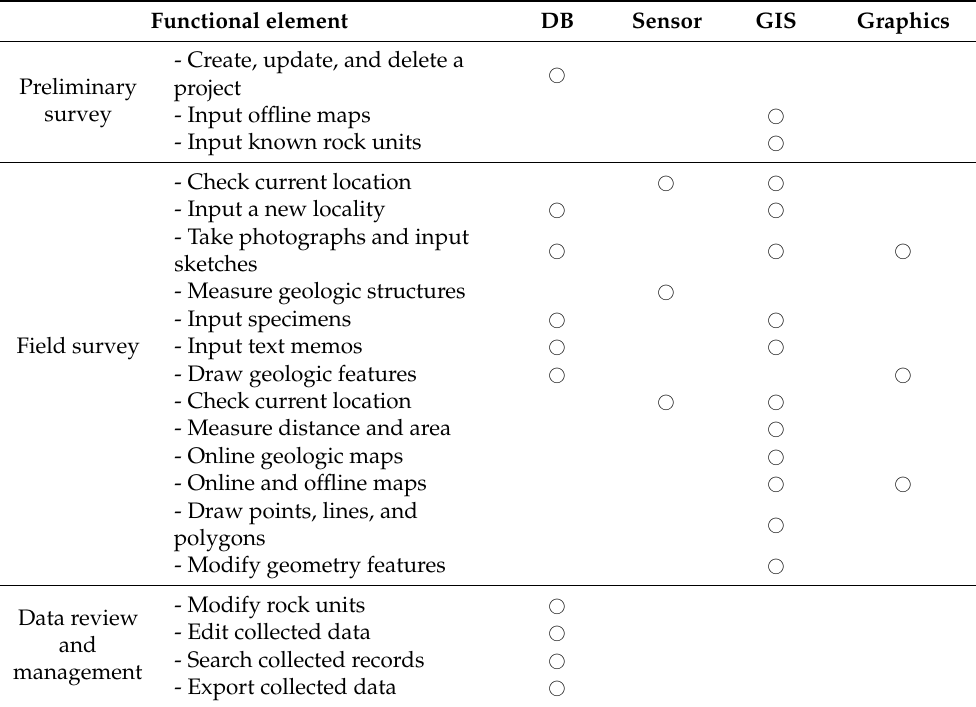
Table 5. Technical elements of implemented functions of the field geological survey